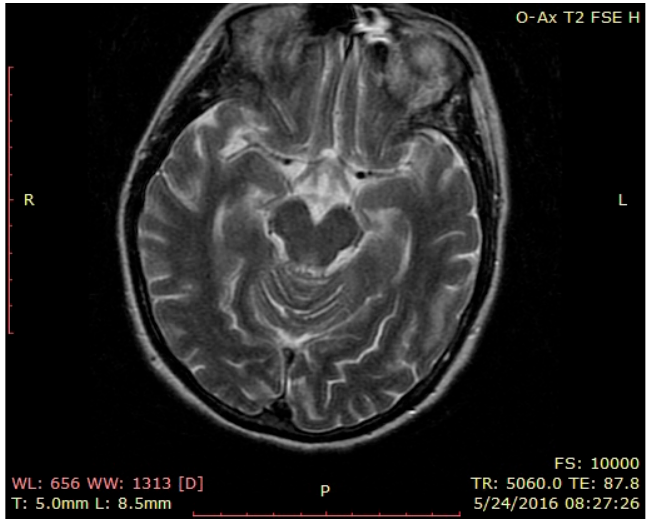
Figure 1. Brain MRI—normal findings (T2 weighted brain scan), axial temporal image.